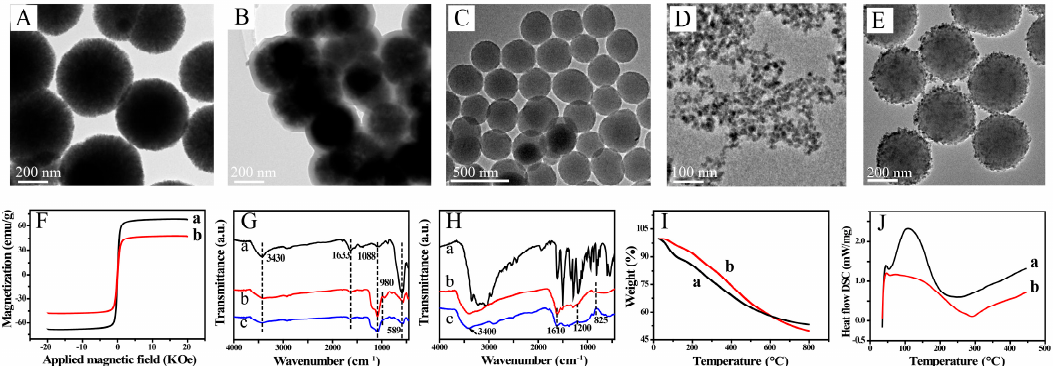
Figure 1. Transmission electron microscopy (TEM) images of Fe 3 O 4 ( A ), Fe 3 O 4 @SiO 2 ( B ), PDA ( C ), CuNPs ( D ) and PDA@CuNPs ( E ); ( F ) vibrating sample magnetometry curves for (a) Fe 3 O 4